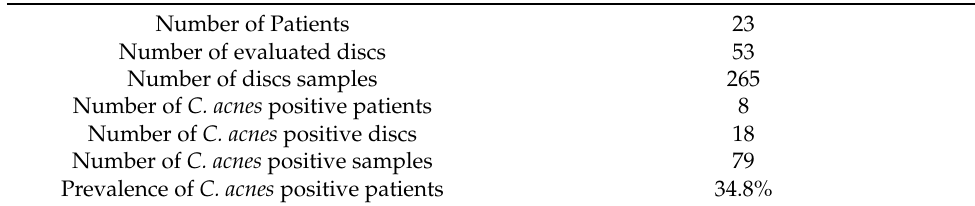
Table 4. Cutibacterium acnes isolation statistics according to the number of patients included in the study.